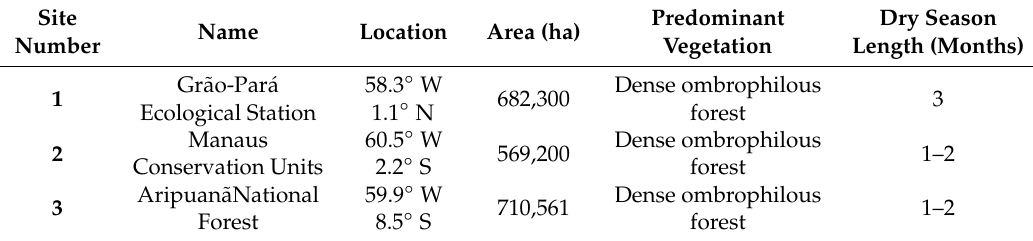
Table 1. Description of the three sites selected for analysis.